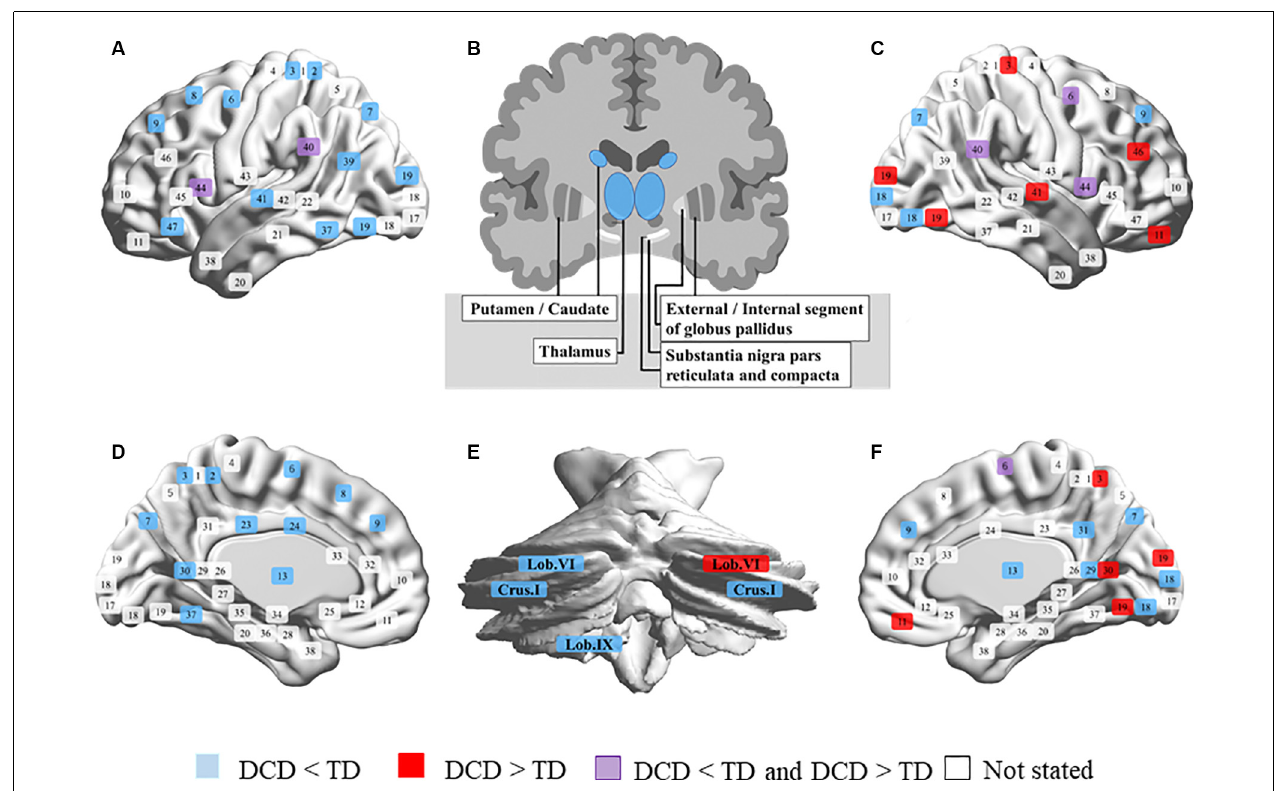
FIGURE 1 | Comparison of brain activity in developmental coordination disorder (DCD) and typical development (TD). (A) Left outside of the sagittal plane. (B) Coronal plane of the basal ganglia. (C) Right outside of the sagittal plane. (D) Left inside of the sagittal plane. (E) Coronal plane of the cerebellum. (F) Right inside of the sagittal plane. Brodmann area (BA) 1, 2, 3, postcentral gyrus; 4, precentral gyrus; 5, superior parietal lobule; 6, premotor cortex and supplementary motor cortex; 7, superior parietal lobule; 8, frontal eye fields; 9, dorsolateral prefrontal cortex; 10, anterior prefrontal cortex; 11, 12, superior frontal gyrus; 13, insular cortex; 17, primary visual cortex; 18, secondary visual cortex; 19, associative visual cortex; 20, inferior temporal gyrus; 21, middle temporal gyrus; 22, superior temporal gyrus; 23, 24, 28–33, cingulate cortex; 25, subgenual area; 26, ectosplenial portion of the retrosplenial region of the cerebral cortex; 27, piriform cortex; 34, dorsal entorhinal cortex; 35, 36, perirhinal cortex and ectorhinal area; 37, fusiform gyrus; 38, temporal pole; 39, angular gyrus; 40, supramarginal gyrus; 41, 42, primary auditory cortex; 43, primary gustatory cortex; 44, pars opercularis, part of the inferior frontal gyrus; 45, pars triangularis, part of the inferior frontal gyrus; 46, dorsolateral prefrontal cortex; 47, pars orbitalis, part of the inferior frontal gyrus.